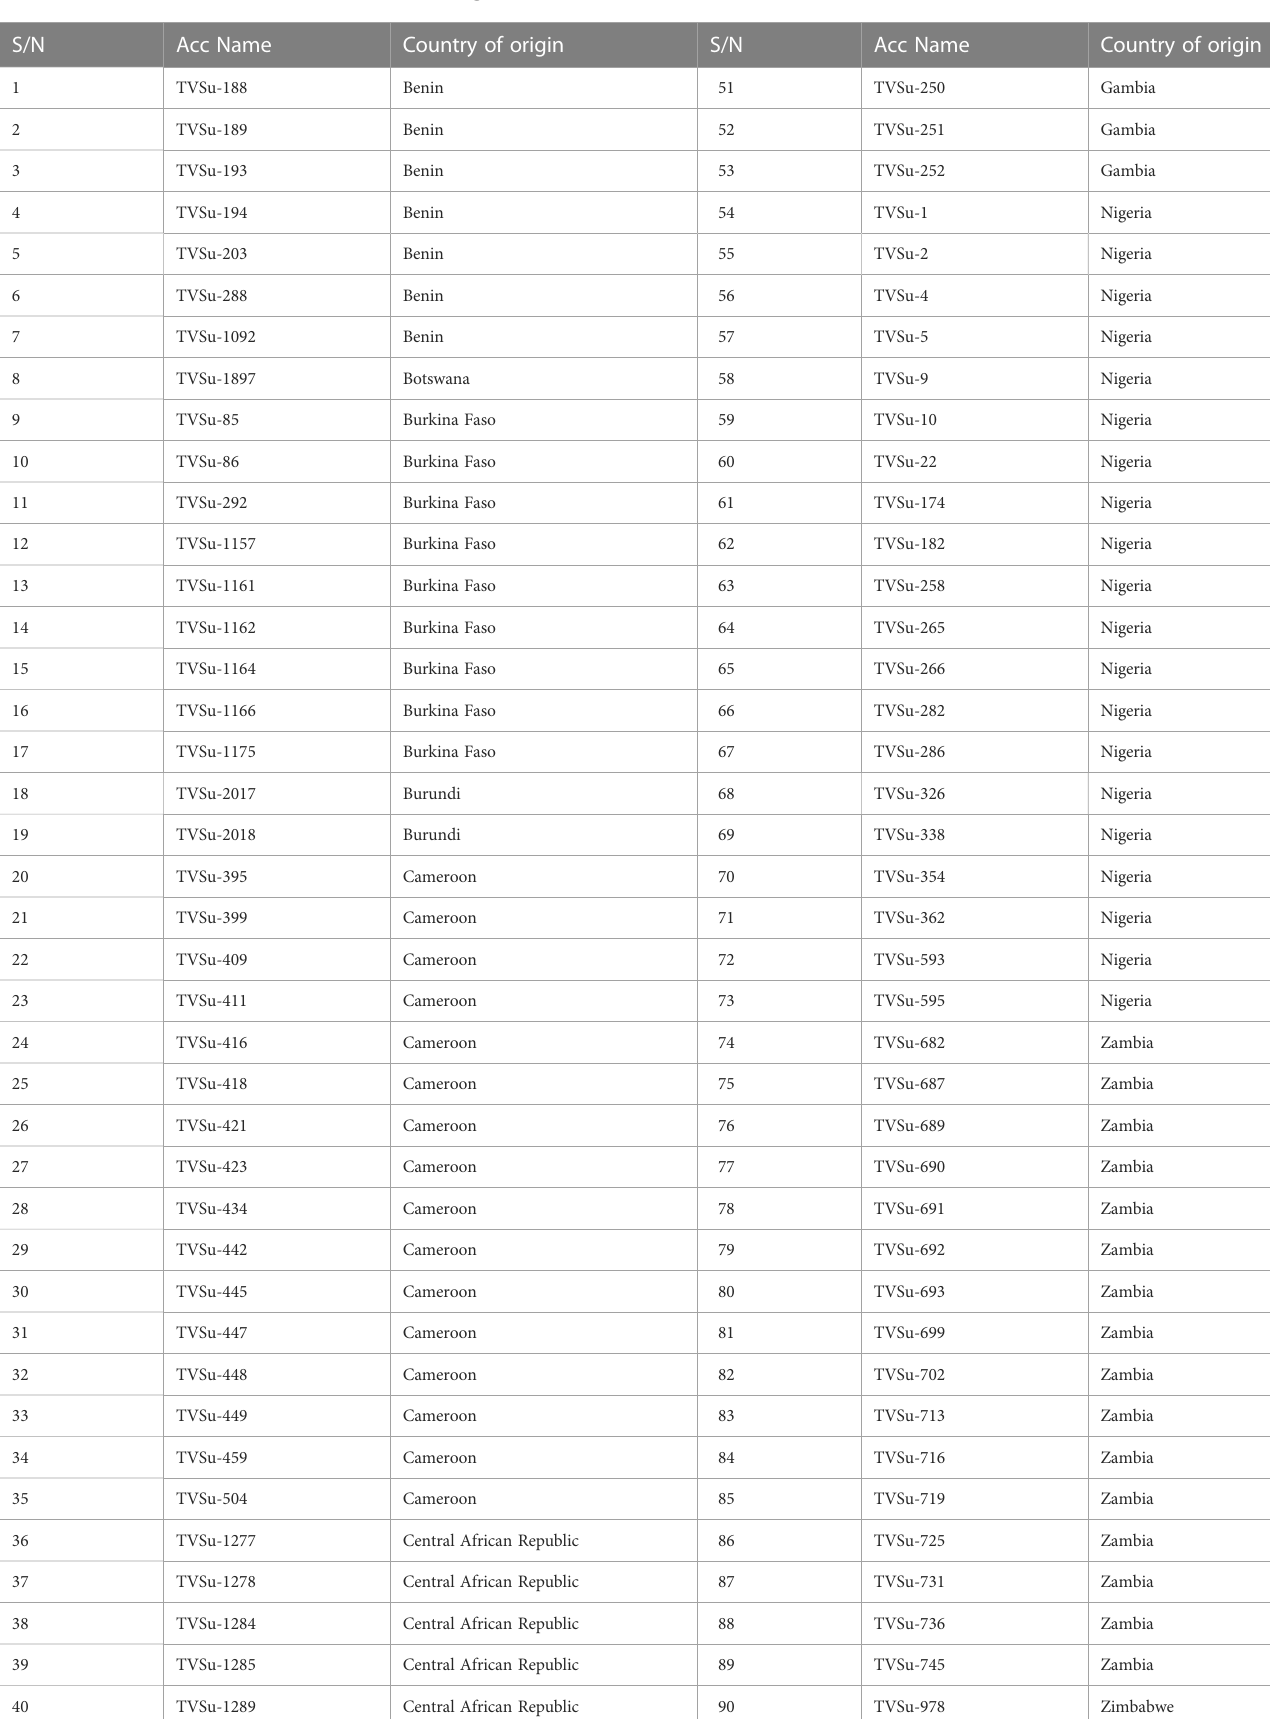
TABLE 1 List of the accessions with their countries of